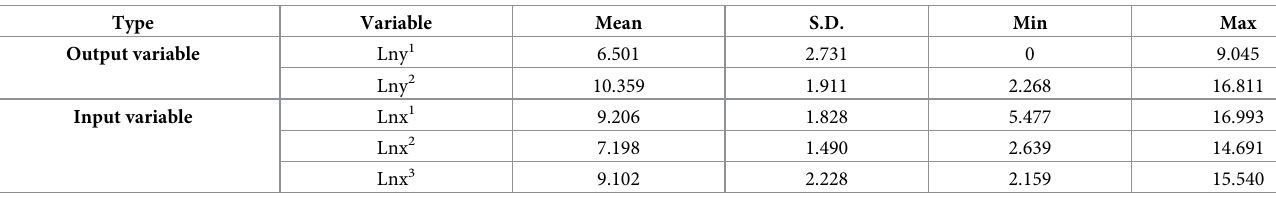
Table 2. Descriptive statistics of input-output